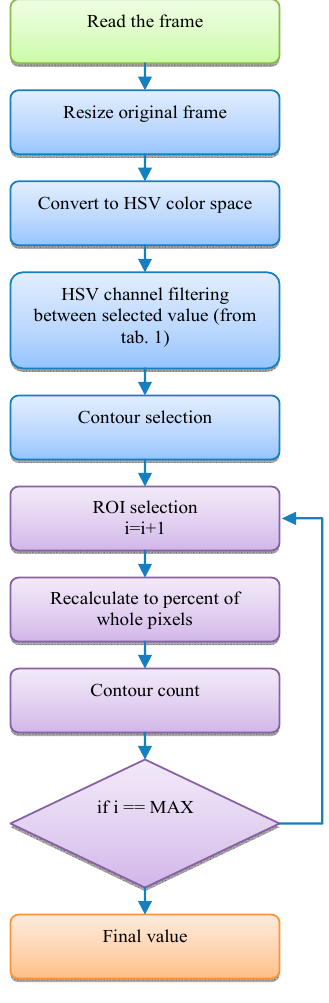
Figure 5. Image processing algorithm.